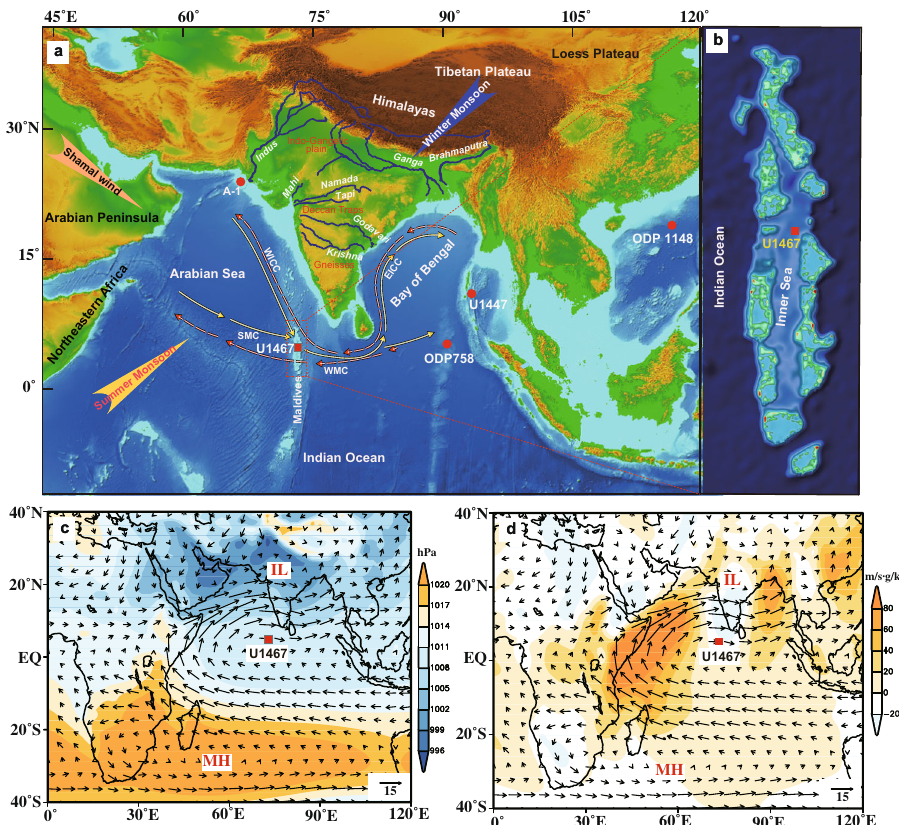
Fig.1|Generalinformationaboutthestudyarea.a Bathymetricmapshowingthe location of IODP Exp. 359 Site U1467 and other sites mentioned in the text. The circulations (modi fi ed after ref. 55 ) in the northern Indian Ocean in summer (thick yellow line) and winter (dashed pink line) are indicated, including the East India Coastal Current (EICC), West India Coastal Current (WICC), Summer Monsoon Current (SMC) and the Winter Monsoon Current (WMC). b Map showing the northern part of the Maldives. c, d Model-exported sea-level pressure (units: hPa),